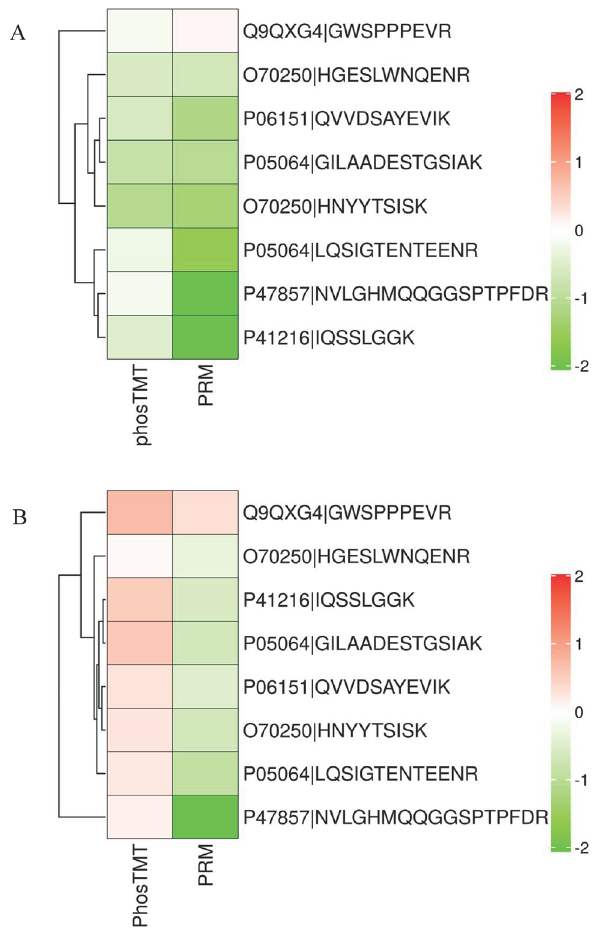
Figure 8. Heat map summary of 8 selected phosphopeptides in PRM verification (right) and TMT phosphoproteomics (left) treated with PZH ( A ) and sorafinib ( B ). In the heatmaps, average expression level of 8 phosphorylated peptides displayed in Table 3 were presented as different colour, where red represents significantly up-regulated phosphorylated peptide, green represents significantly down-regulated phosphorylated